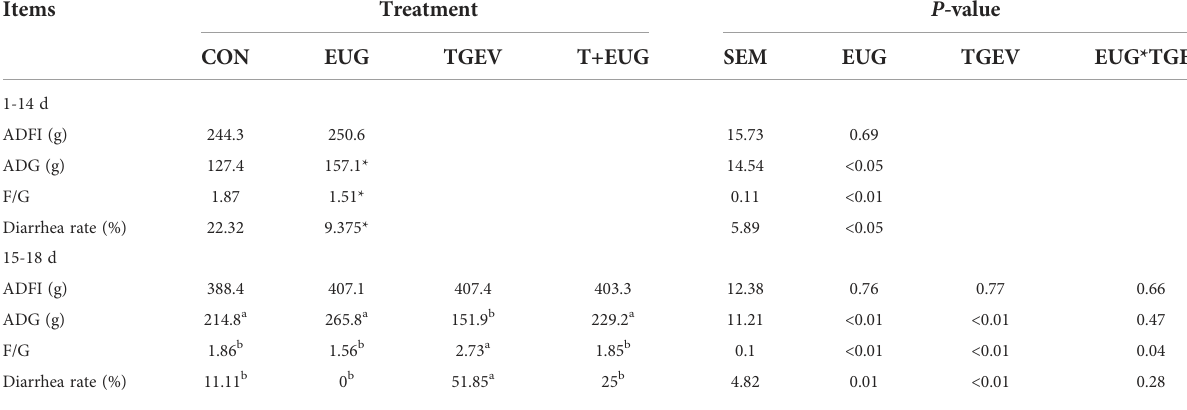
TABLE 2 The effects of eugenol and/or TGEV challenge on growth performance and diarrhea of weaned piglets. Items